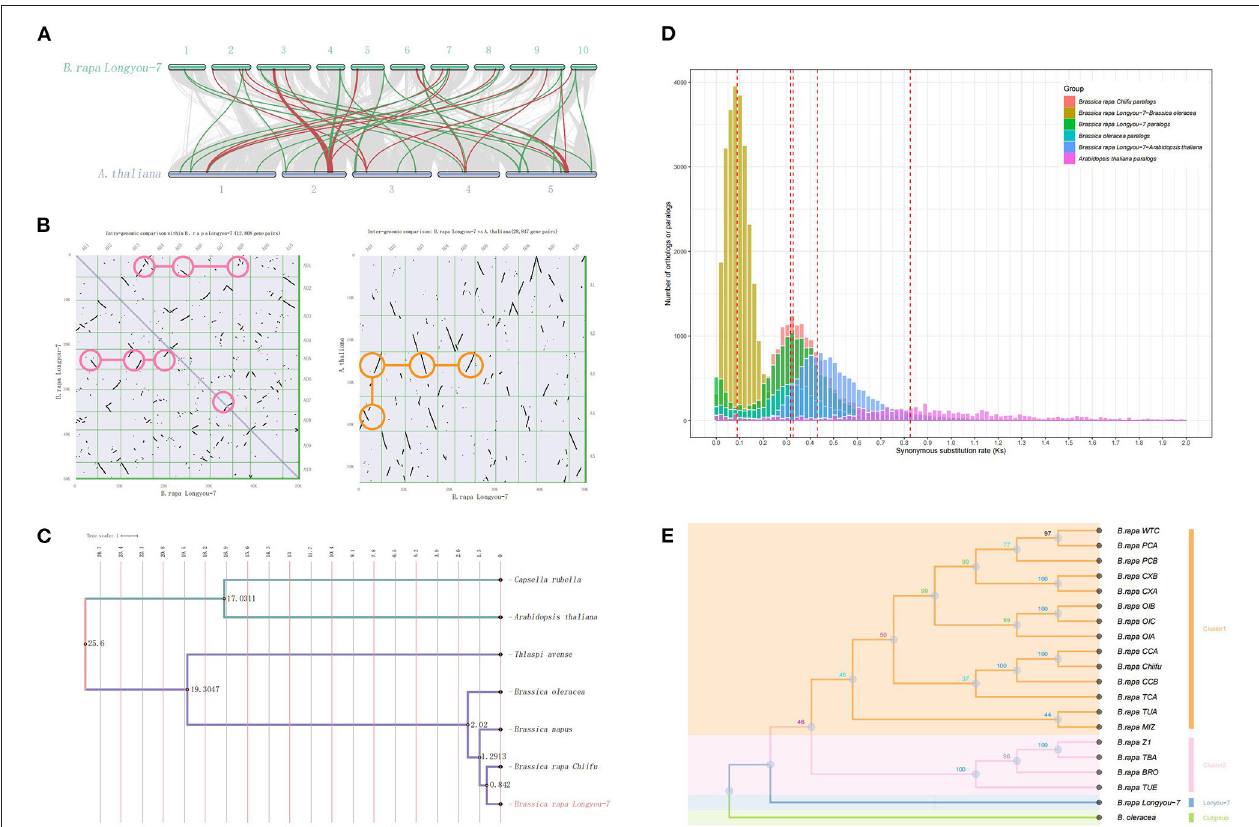
FIGURE 2 | WGT and evolution of B. rapa “Longyou-7” genome. (A) Macrosynteny patterns reflect a 3:1 syntenic depth between B. rapa “Longyou-7” and A. thaliana genomes. Green linkages mark examples where three copies of a gene on chromosomes of Arabidopsis are present in the “Longyou-7” genome; (B) Dot plot illustrating the comparative analysis within the “Longyou-7” and Arabidopsis genomes, the pink circles highlight several major triplication events, the dots represent the synteny gene pairs, and the orange circles highlight an example of 3:1 synteny depth; (C) Phylogenetic tree constructed with single-copy orthologs of seven species with divergence time annotated. (D) Ks (Synonymous substitution rate) distributions for Brassica rapa paralogs and orthologs with other genomes: A. thaliana, B. oleracea, and B.rapa Chiifu ; (E) Species tree constructed using the maximum likelihood method with single-copy ortholog sequences of B. rapa “Longyou-7” genome and 18 reported B. rapa genomes, with B. oleracea as the outgroup.